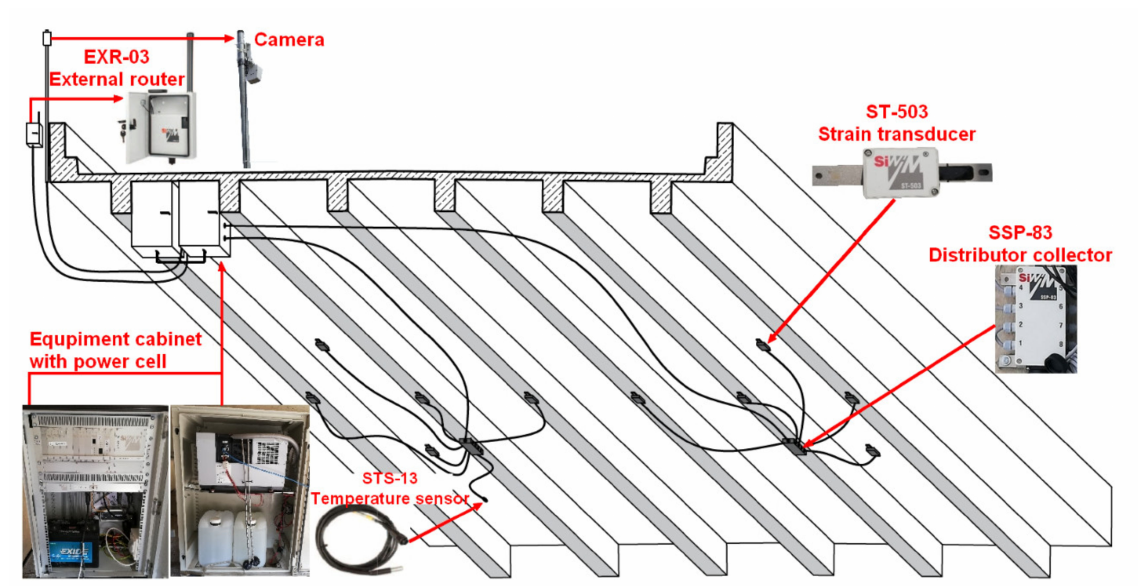
Figure 3. Scheme of the measuring apparatus